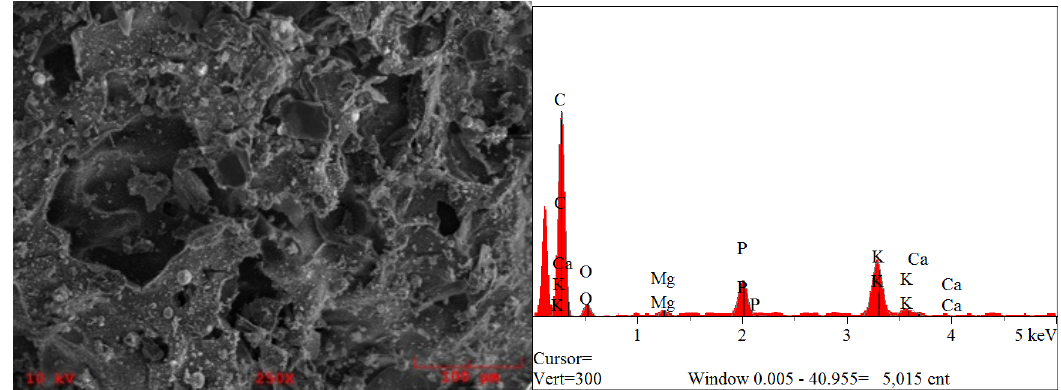
Figure 3. Surface area analysis from corn biochar (Elements from left to right K, Ca, C, O, Mg, P, K, Ca).